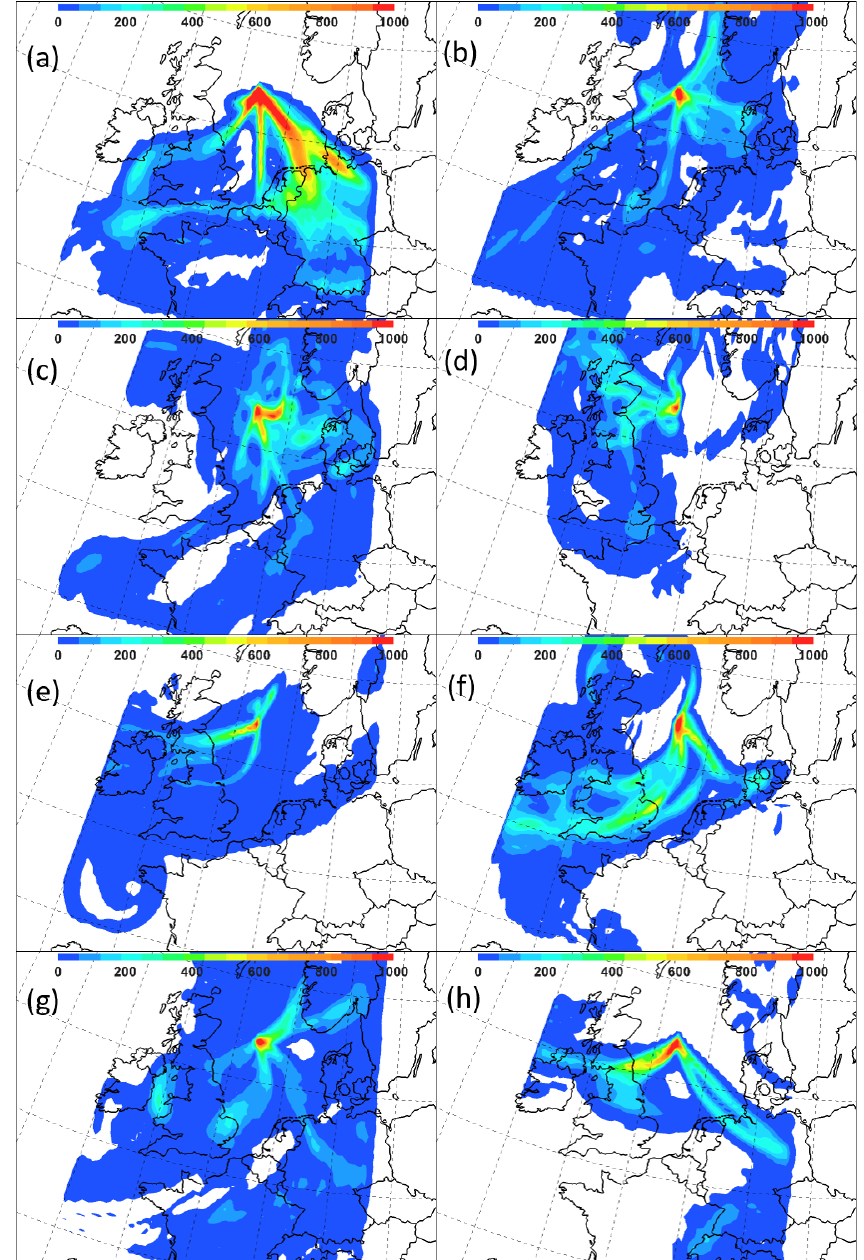
Figure 9. Weekly HYSPLIT calculations of methane concentration over the European domain for weeks commencing 28 March (a) , 4 April (b) , 11 April (c) , 18 April (d) , 25 April (e) , 2 May (f) , 9 May (g) , and 16 May (h) . Concentrations (colour shaded, ppb m) are vertically integrated from 0 to 2000m: (integrated concentrations < 1ppbm not